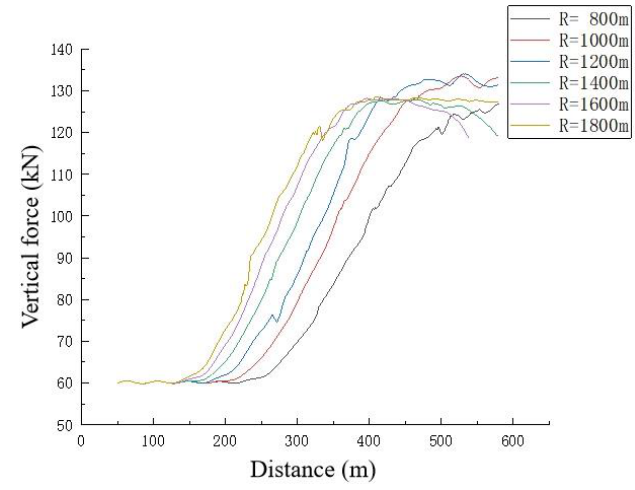
Figure 14. Variation of vertical force at critical derailment speed.